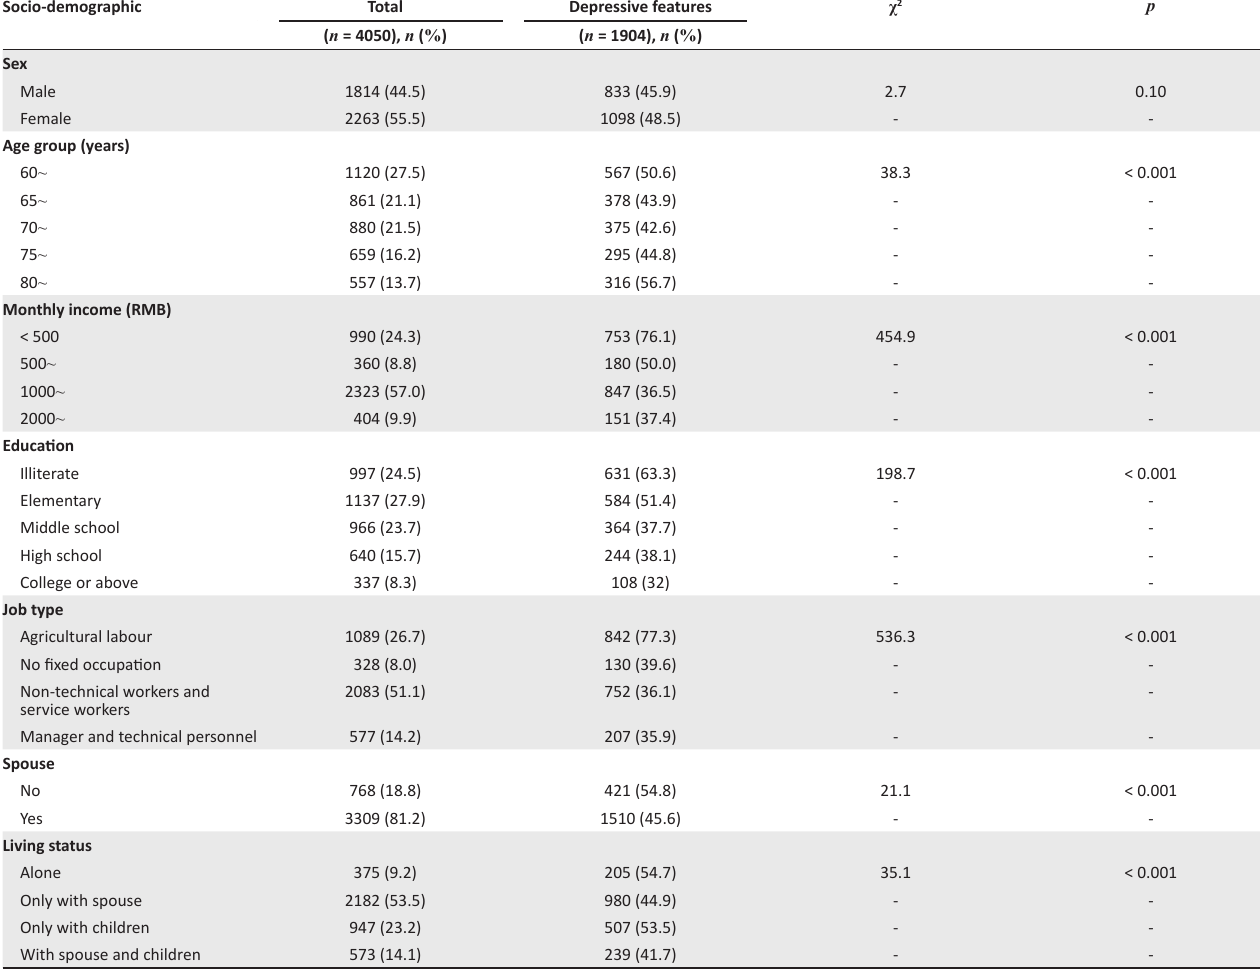
TABLE 1: Comparison of socio-demographic characteristics of the elderly by depressive features. Socio-demographic Total Depressive